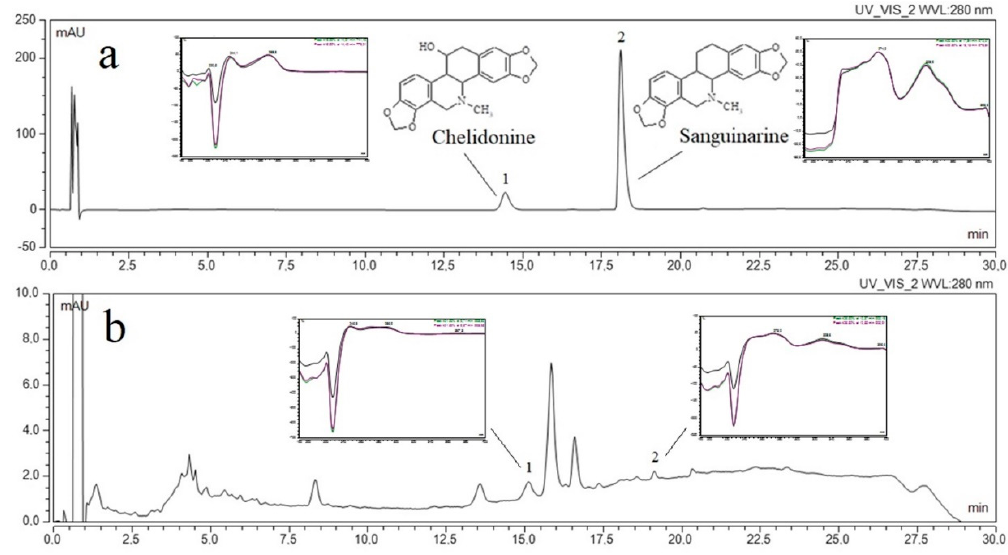
Figure 1. The UHPLC chromatogram of analytical standards (chelidonine (1) and sanguinarine (2)) ( A ) Chelidonii herba lyophilized extract ( B ).